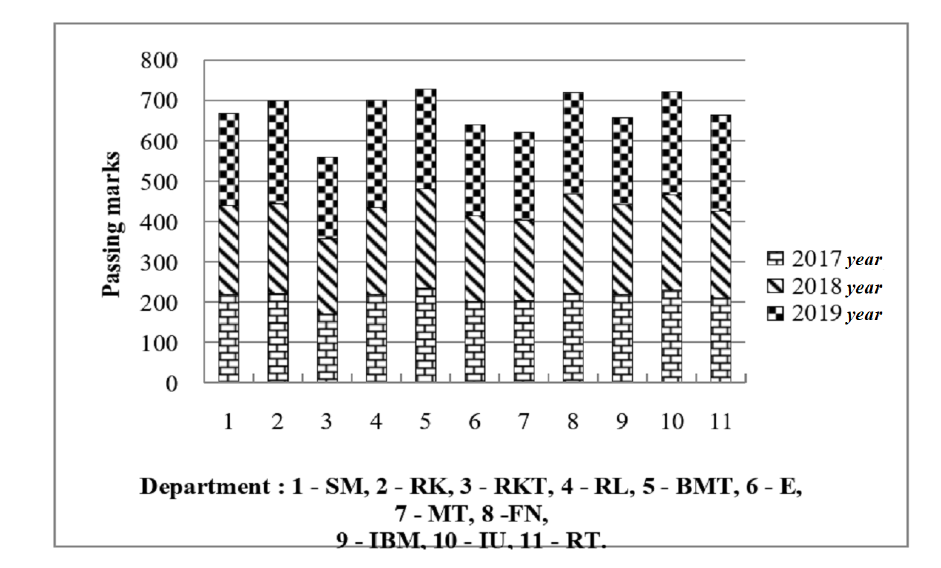
Fig. 4. Passing marks at BMSTU departments in the 2017, 2018, 2019 years.